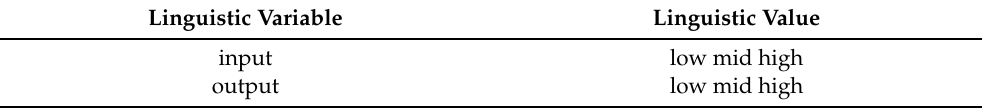
Figure 3. Structure of the FIS based energy/power management system. Table 1. Generic FIS input and output linguistic variables with their linguistic values.